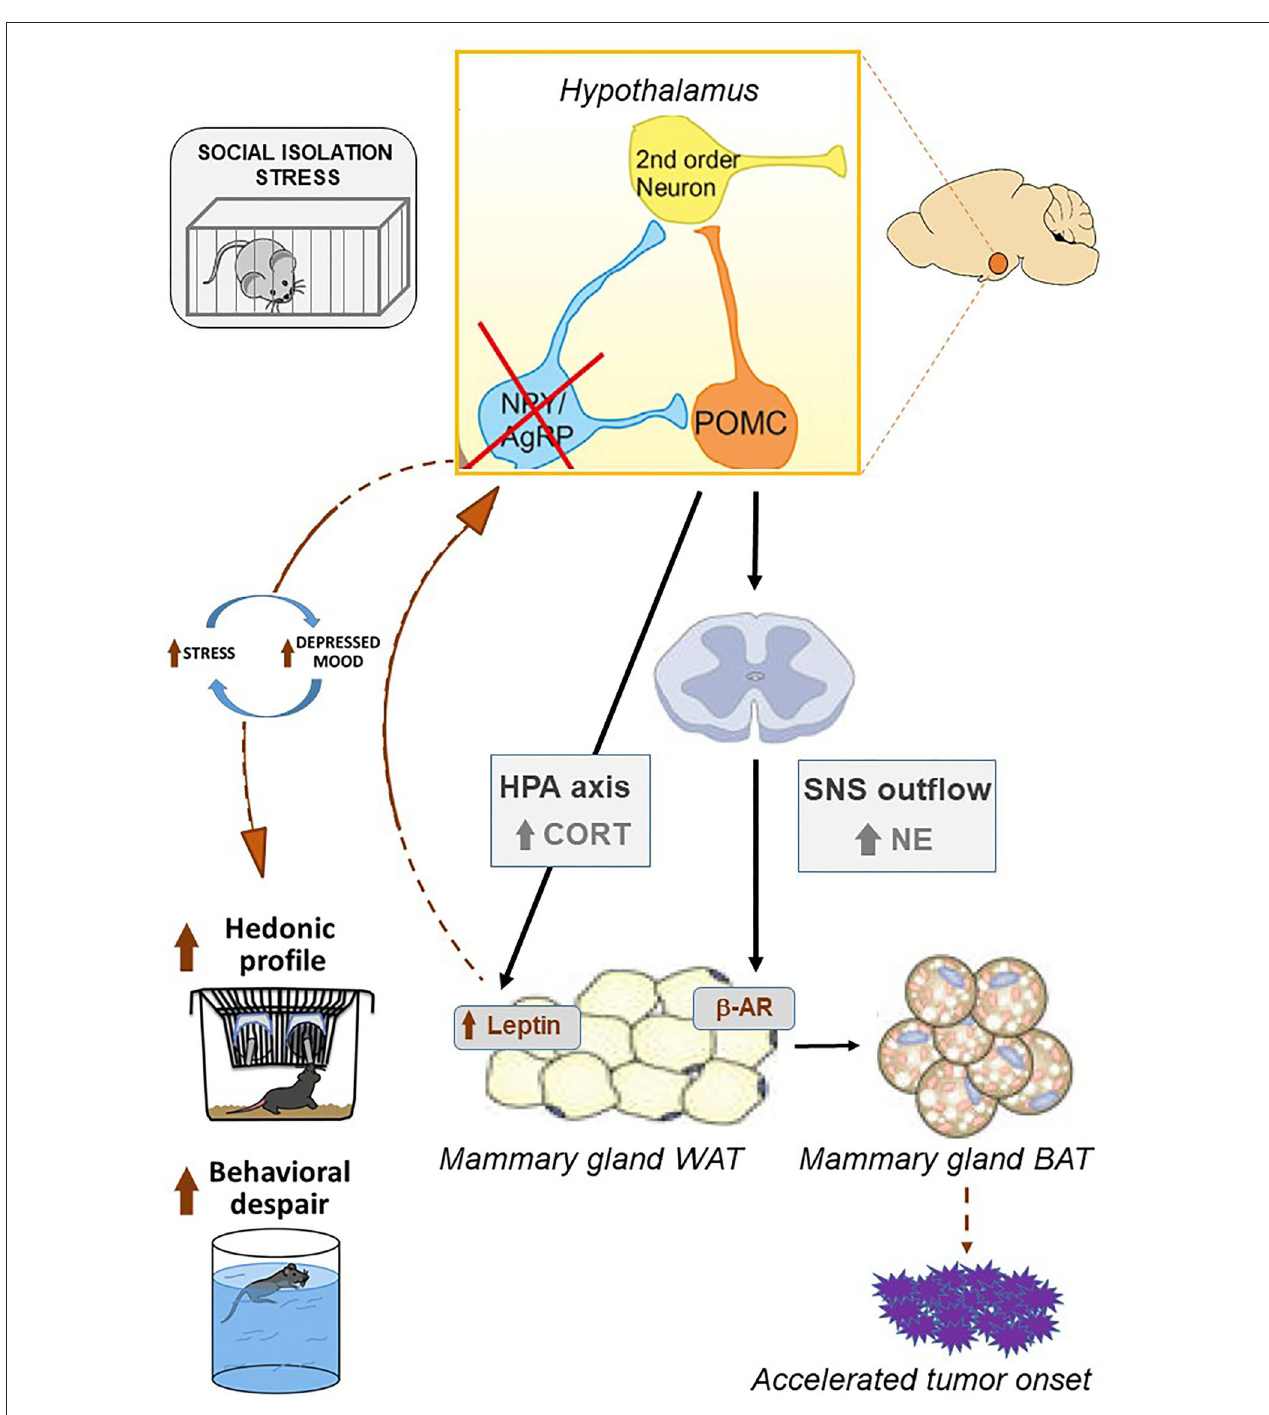
FIGURE 6 | Chronic social isolation stress results in the activation of the hypothalamic-pituitary-adrenal axis. Upon the activation of the HPA axis, corticosterone acts directly on the white adipose tissue by increasing leptin levels. This pro-inflammatory adipokine reaches target neurons in the hypothalamus, resulting in the inhibition of NpY/AgRP signaling that in turn increases the neuronal activity of POMC (Baver et al., 2014; Denis et al., 2015; Fang et al., 2021). As a result, an increase in reward-driven saccharin consumption is observed as well as passive coping strategies in the forced swimming test. The appearance of depressive-like behaviors promotes a feed-forward loop promoting chronic stress. Likewise, hypothalamic signaling via POMC neurons triggers the activation of the sympathetic nervous system that, by secreting norepinephrine, reaches beta-adrenergic receptors within WAT, promoting the development of brown adipose tissue (Dodd et al., 2015; Caron et al., 2018). BAT is characterized by increased metabolic rate and may, in turn, accelerate tumor onset in the MMTVNeuTg mouse model. Picture modified from Caron et al. (2018), Denis et al. (2015), and Franklin et al. (2012).